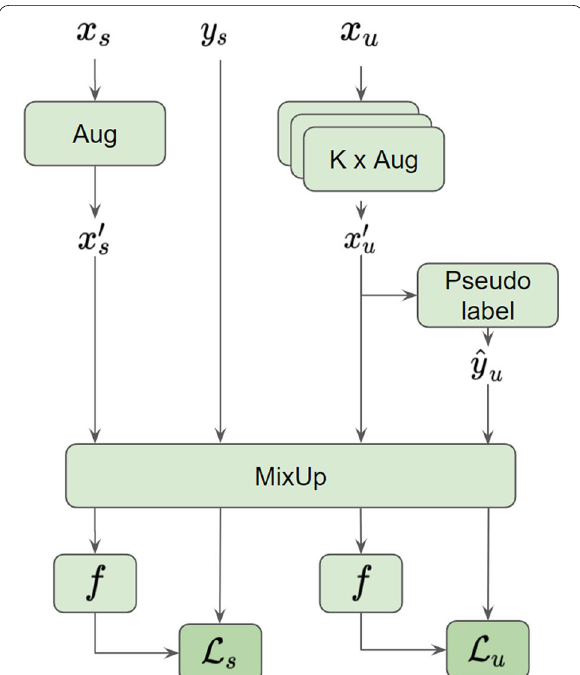
Fig. 3 MM workflow. K augmentations are applied to the unlabeled data x u , and the averaged model predictions are used as pseudo labels ˆ y u . The labeled and augmented unlabeled data are mixed up and used to compute the supervised and unsupervised loss